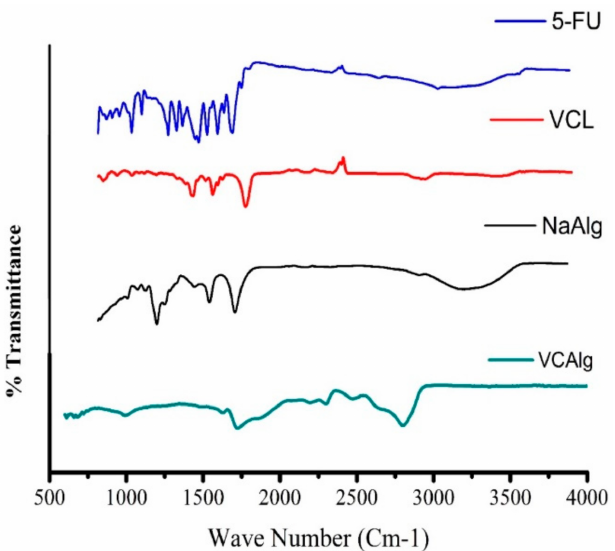
Figure 2. FTIR spectra’s of pure 5-FU, pure NVCL, pure NaAlg, and bare chemically grafted Poly (NVCL-g-NaAlg) in situ depot gel